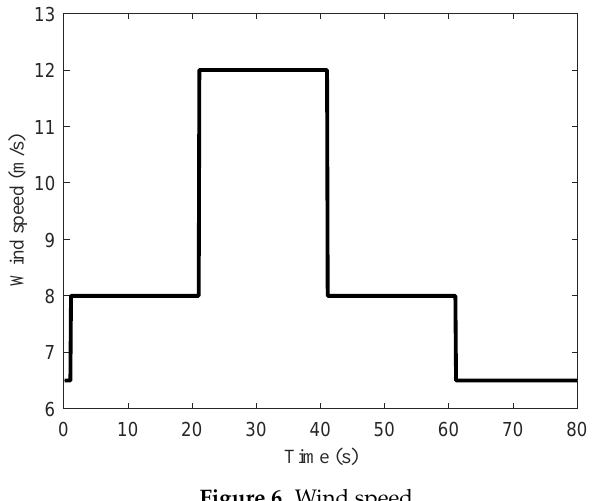
Figure 6. Wind speed.